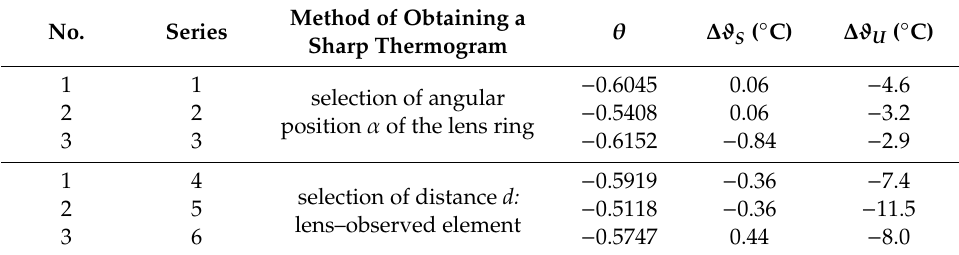
Table 1. Designated values of measurement errors ∆ ϑ S and ∆ ϑ S and bias θ .